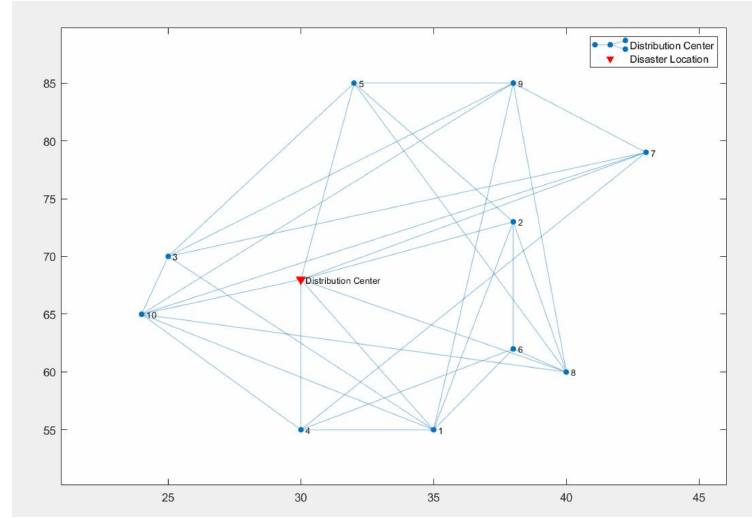
Figure 2. Network topology in the affected area.